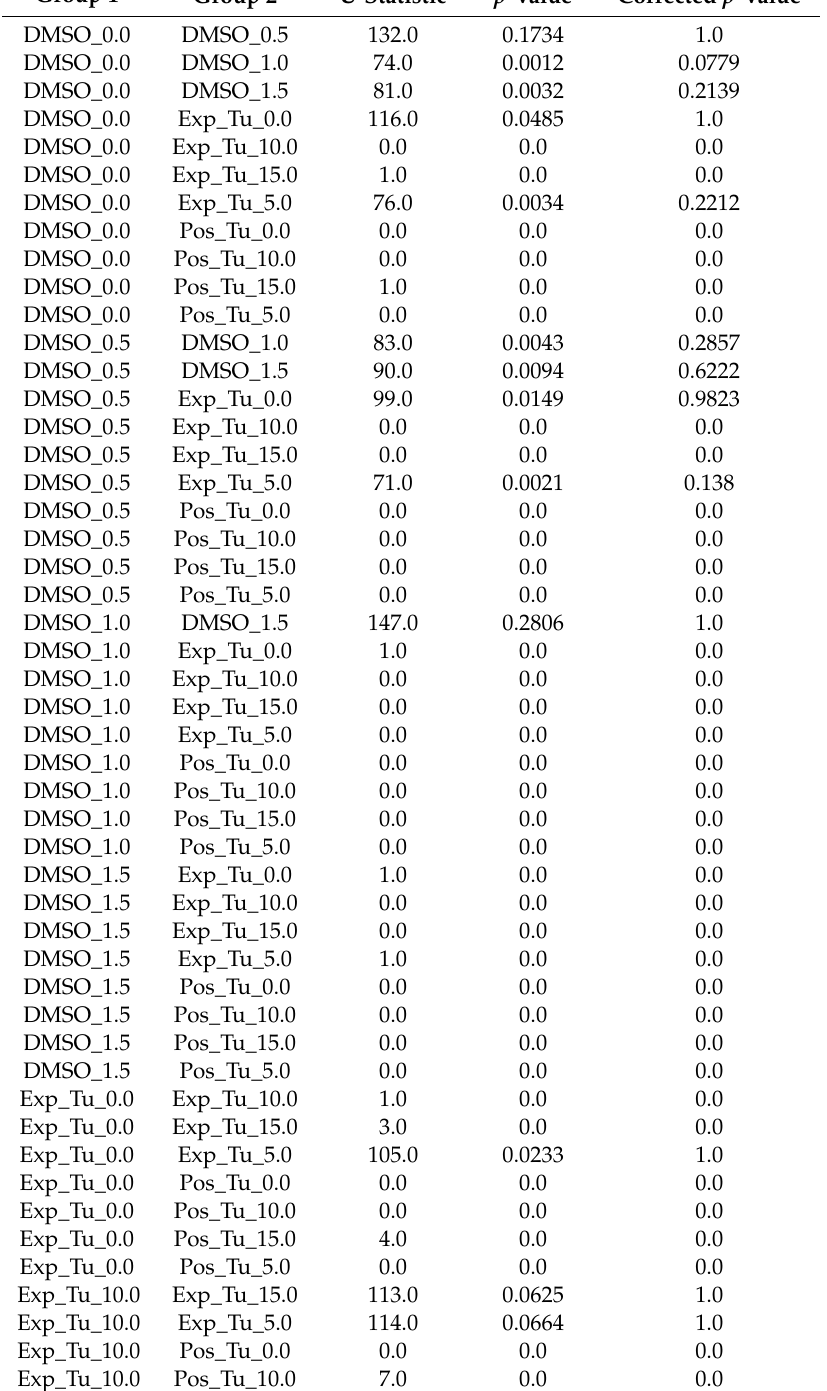
Table 4. Statistical Analysis of Red Cells Percentage Changes at the End of the ER stress Time Course Between Di ff erent Control and Experimental Groups, Treated with Di ff erent DMSO and Tunicamycin Doses 1